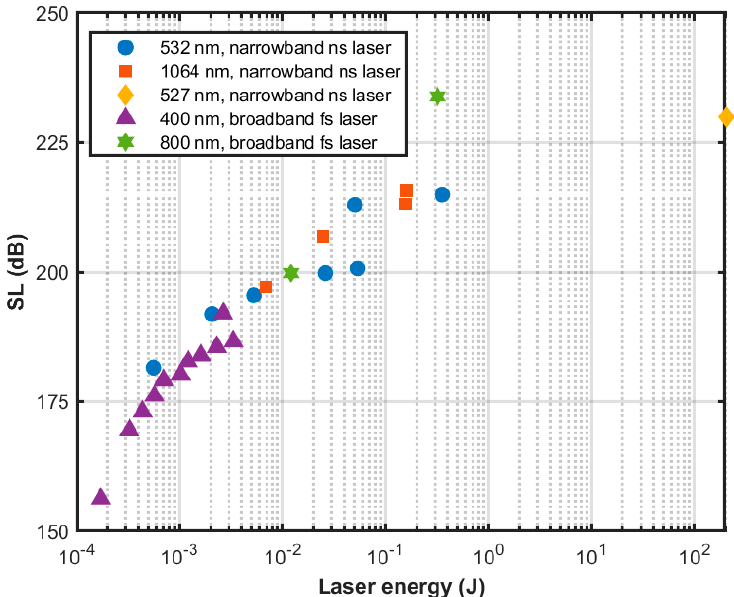
Figure 11. Acoustic source level as a function of laser pulse energy for non-linear photoacoustic generation with narrowband and broadband lasers.